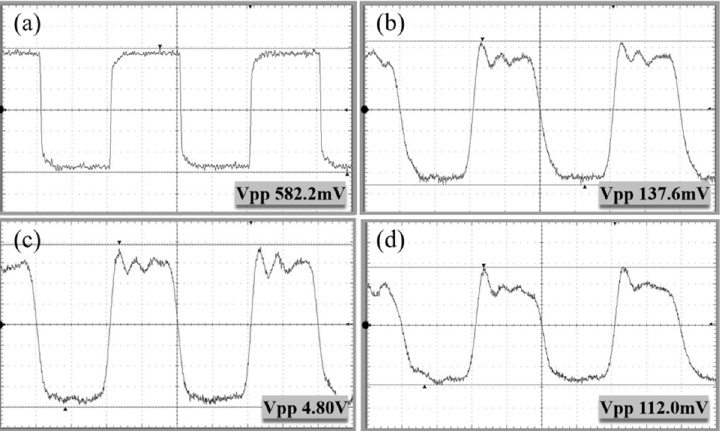
Figure 5. Signal observed on oscilloscope after ( a ) Tx.1, ( b ) Rx.1, ( c ) amplifier, ( d )